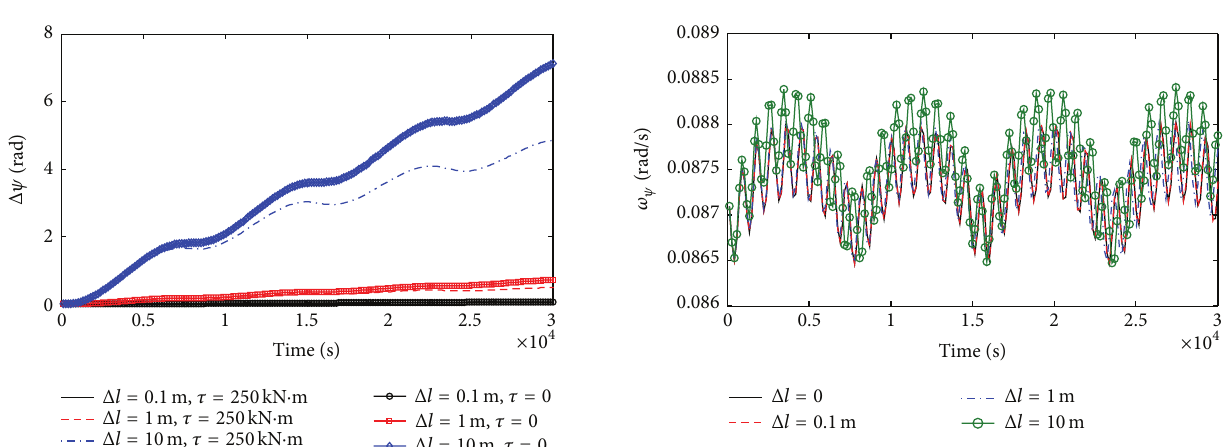
Figure16:Timehistoryofangularvelocity ̇𝜓 withdifferent Δ𝑙 , 𝜏 = 0 (simulation step = 150).